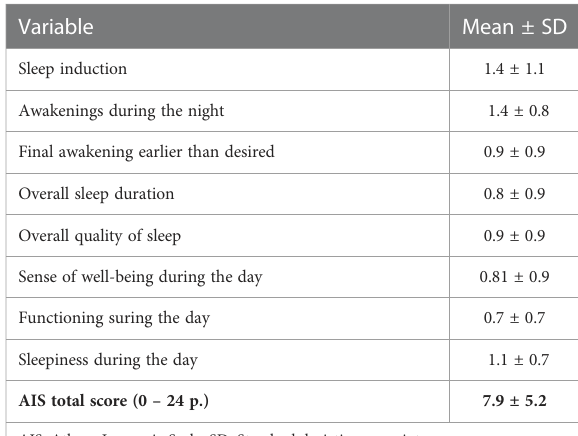
TABLE 2 Components of AIS (0 – 3 p.).